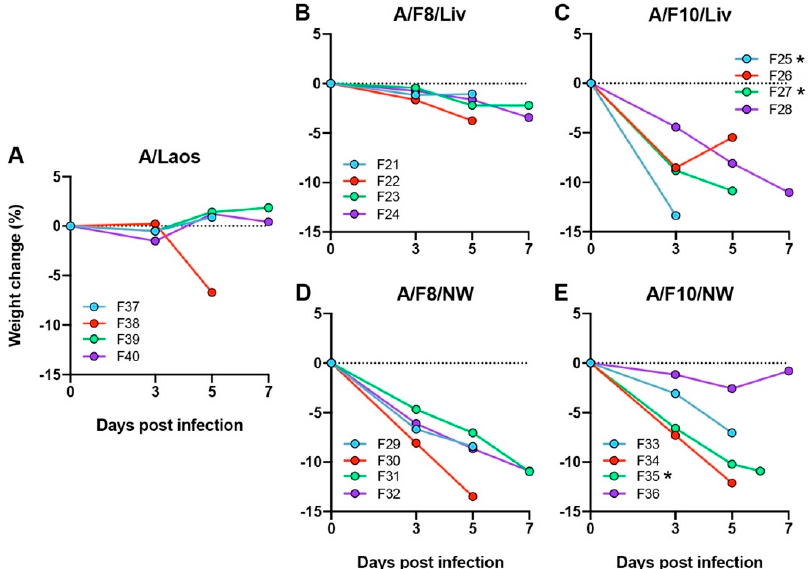
Figure 3. Weight changes following inoculation of ferrets with second passage H5N1 viruses. ( A ) A / Laos (PB2 627E); ( B ) A / F8 / Liv (PB2 627E); ( C ) A / F10 / Liv (PB2 627K); ( D ) A / F8 / NW (PB2 627E / K); ( E ) A / F10 / NW (PB2 627E)) H5N1 viruses. Two ferrets from each group were sampled on days 5 and 7 PI. * Ferrets were euthanised earlier than scheduled, at the humane